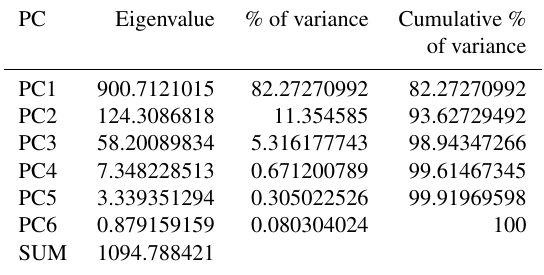
Table 3. Eigenvalues – % of total